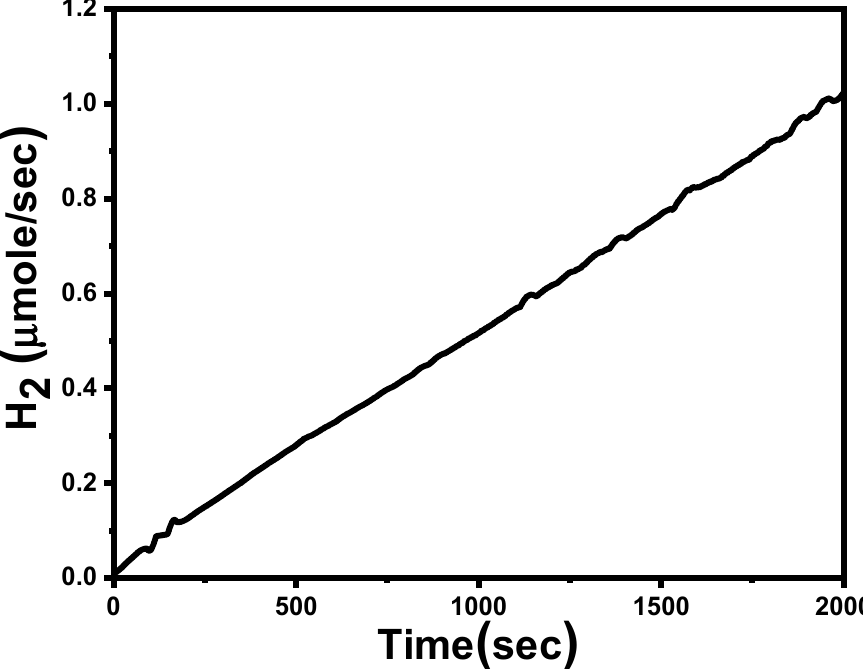
Figure 9. The number of H 2 moles produced as a function of